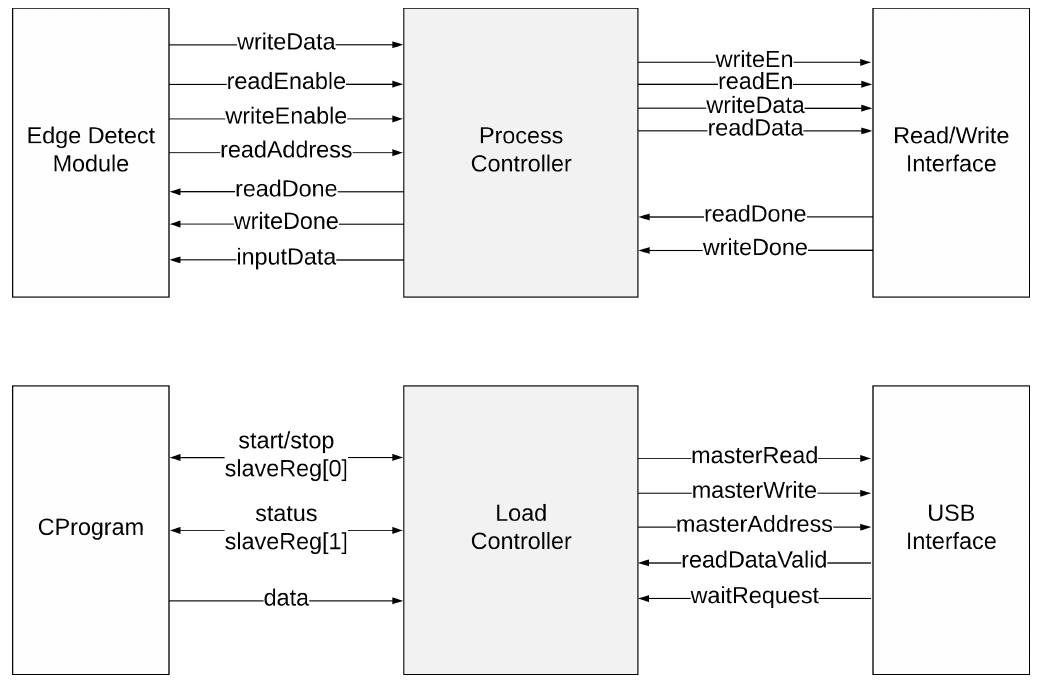
Figure 4. FPGA interface register-transfer level (RTL)